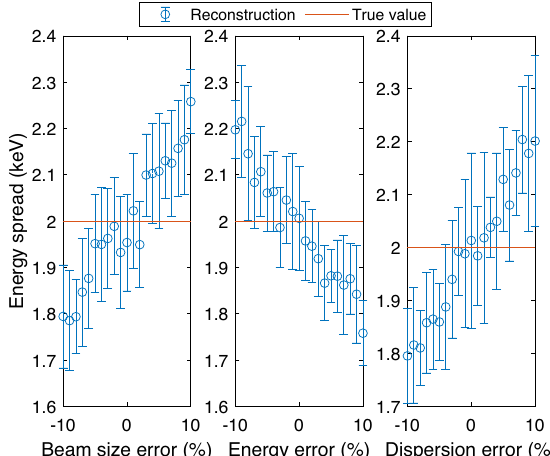
FIG. 5. Reconstructed energy spread as a function of different systematic relative errors: beam size (left), energy (center), and dispersion